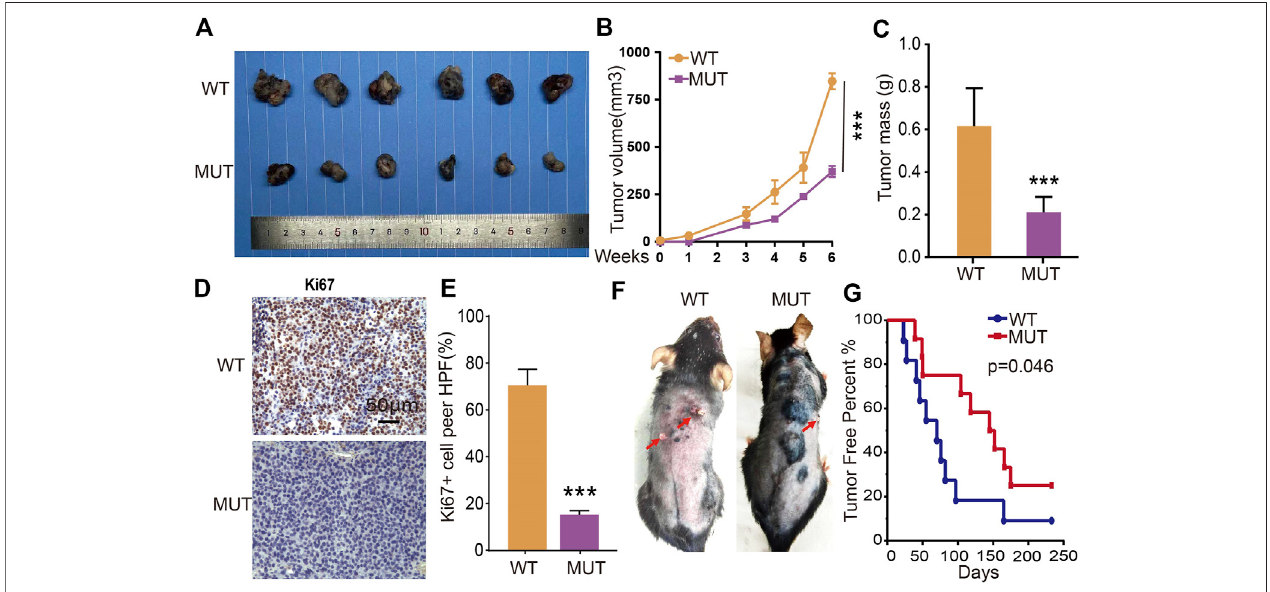
FIGURE 5 | RETSAT (Q247R) mutation inhibits tumor growth in vivo . (A – C) RETSAT mutation inhibits xenograft tumor formation in vivo . Representative xenograft tumor images (A) , tumor masses (B) and tumor volumes (C) . (D,E) Representative IHC staining of Ki67 for indicated xenograft tumors. (F) Representative mice images after DMBA/TPA treatment. WT (cid:1) wild type (RETSATQ/Q). MUT (cid:1) mutant (RETSATR/R). (G) The overall survival (OS) analysis for RETSAT mutation and RETSAT WT mice after DMBA/TPA induced cutaneous keratinocyte carcinoma. * p < 0.05, ** p < 0.01, *** p < 0.001.